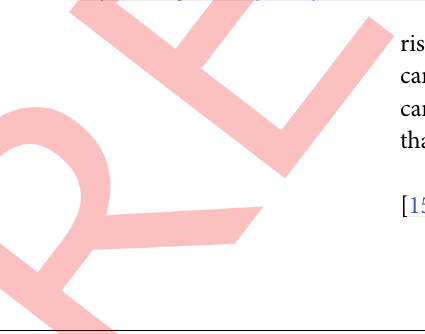
Fig 3. Forest plot of CAR in predicting CSS of patients with GC. (A) The whole patients group; (B) The subgroup analysis by country; (C) The subgroup analysis by treatment; (D) The subgroup analysis by cut-off value; and (E) The subgroup analysis by TNM stage.